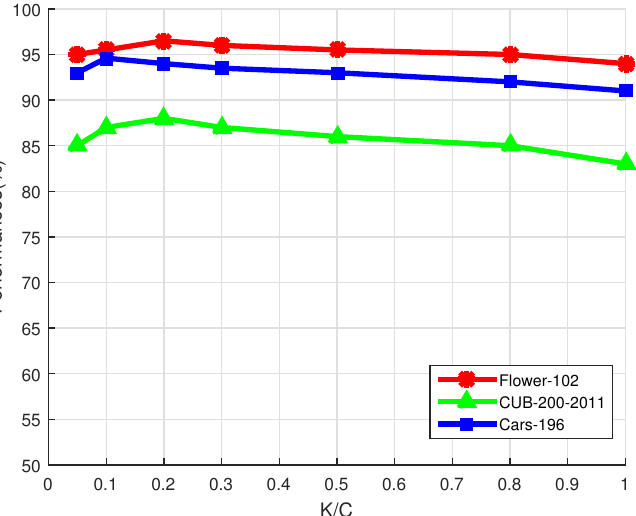
Figure 3. Influence of K on the Flower-102 dataset, the CUB-200-2011 dataset, and the Cars-196